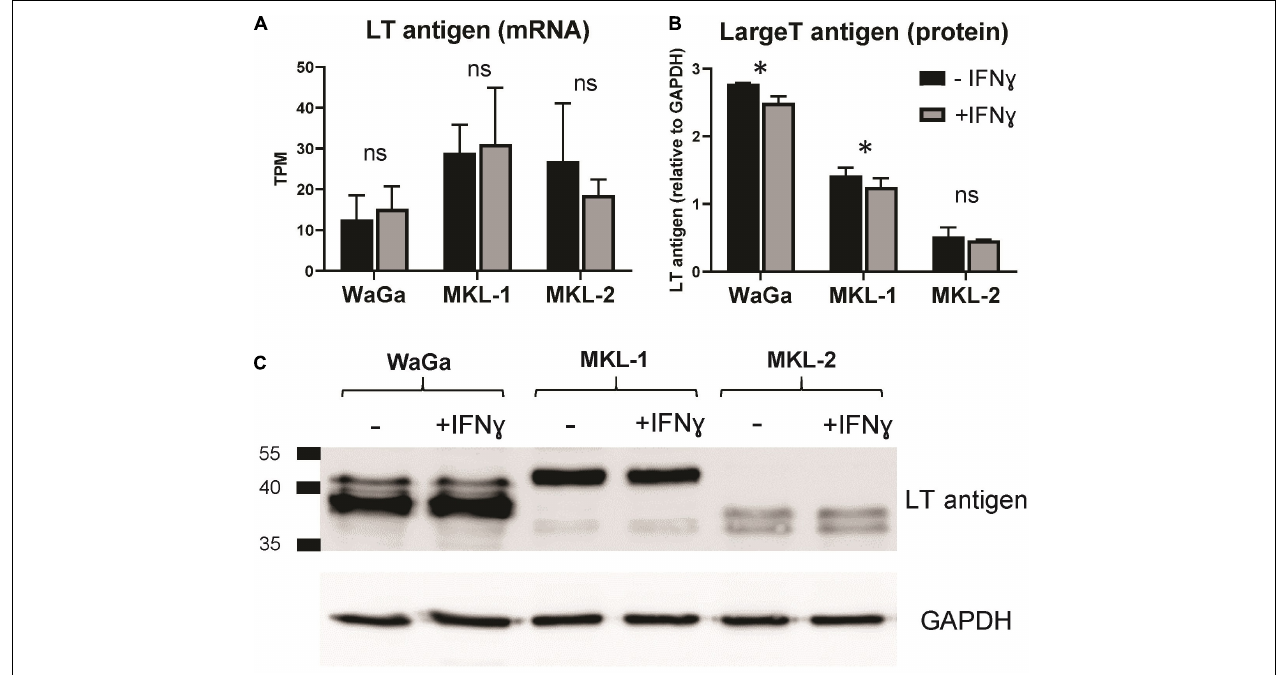
FIGURE 7 | Large T antigen expression before and after IFN γ treatment. (A) TPM values were acquired from our sequencing output. The data represent mean values ± SEM from three independent experiments (two for MKL-1 control). (B) LT antigen expression was analyzed on protein level via Western blot analysis. Expression levels are depicted relative to the loading control GAPDH. The average of three independent experiments ± standard error is indicated. p -values were determined using the paired student’s t -test. ∗ p < 0.05; ∗∗ p < 0.01; ns, not significant. (C) Representative exposure of one western blot. Protein size standard is indicated in